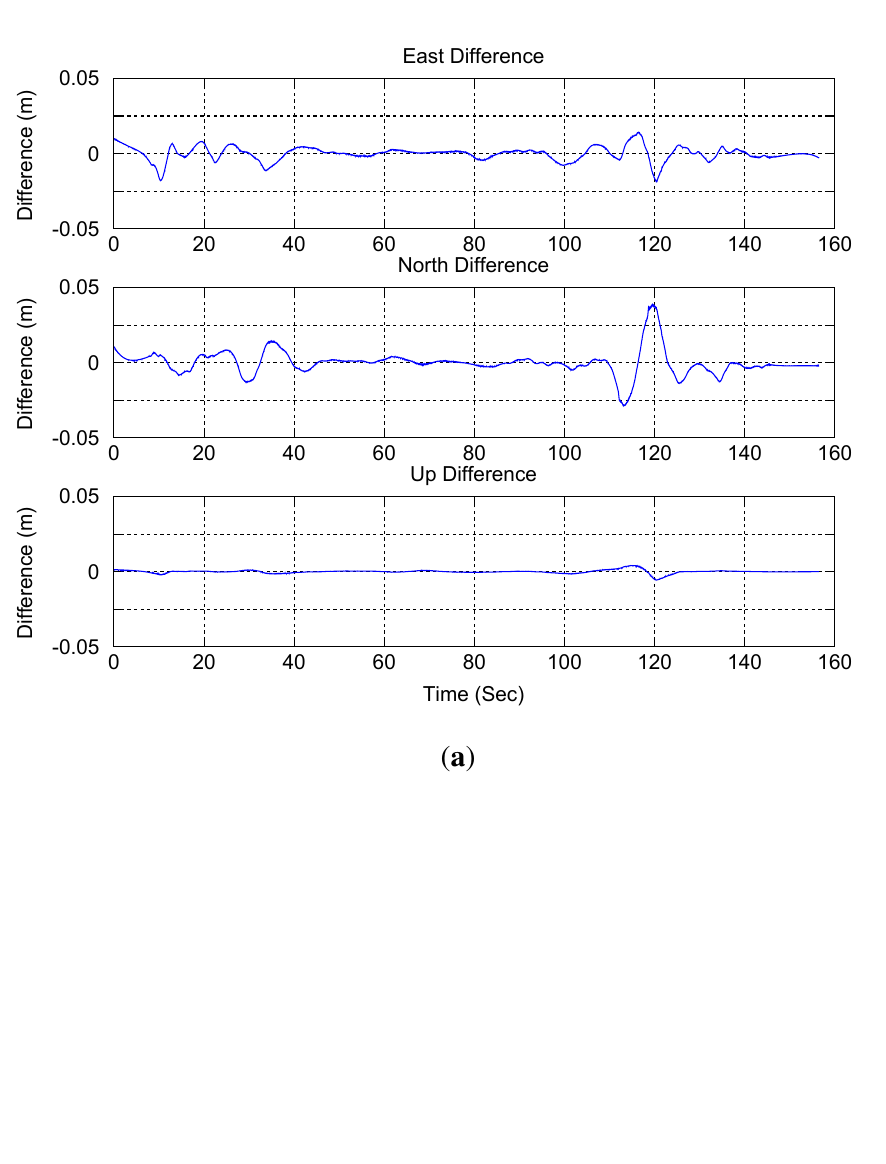
Figure 6. The differences in position ( a ) and orientation ( b ) as estimated by the Sigma Point Kalman Smoother with and without the inclusion of observations of orientation generated by the SfM algorithm. A difference in orientation 0.5 ◦ can result in a 0.2 m difference of a measured point at the nominal flying height used in this